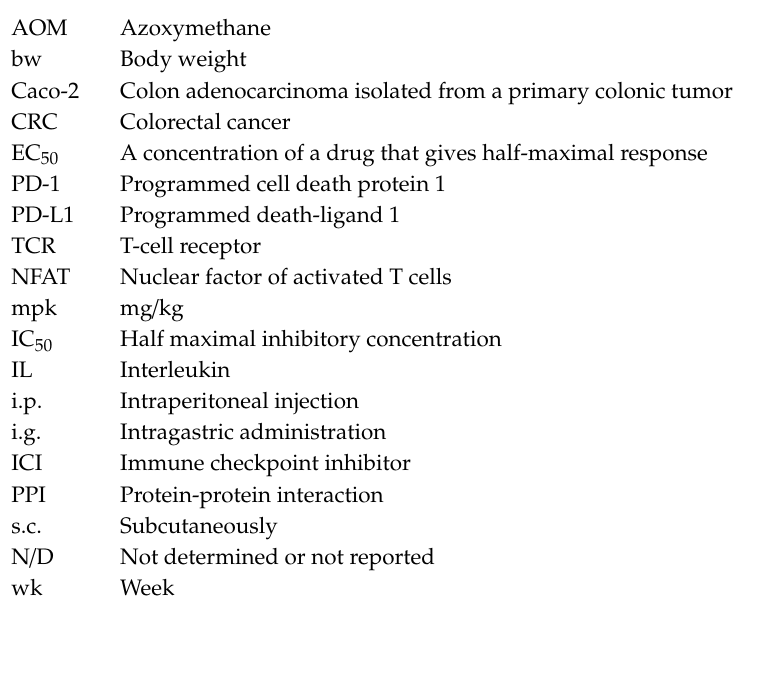
Figure S1: E ff ect of RCE or ellagic acid on cell viability of MC38 cells expressing human PD-L1 (hPD-L1 MC38